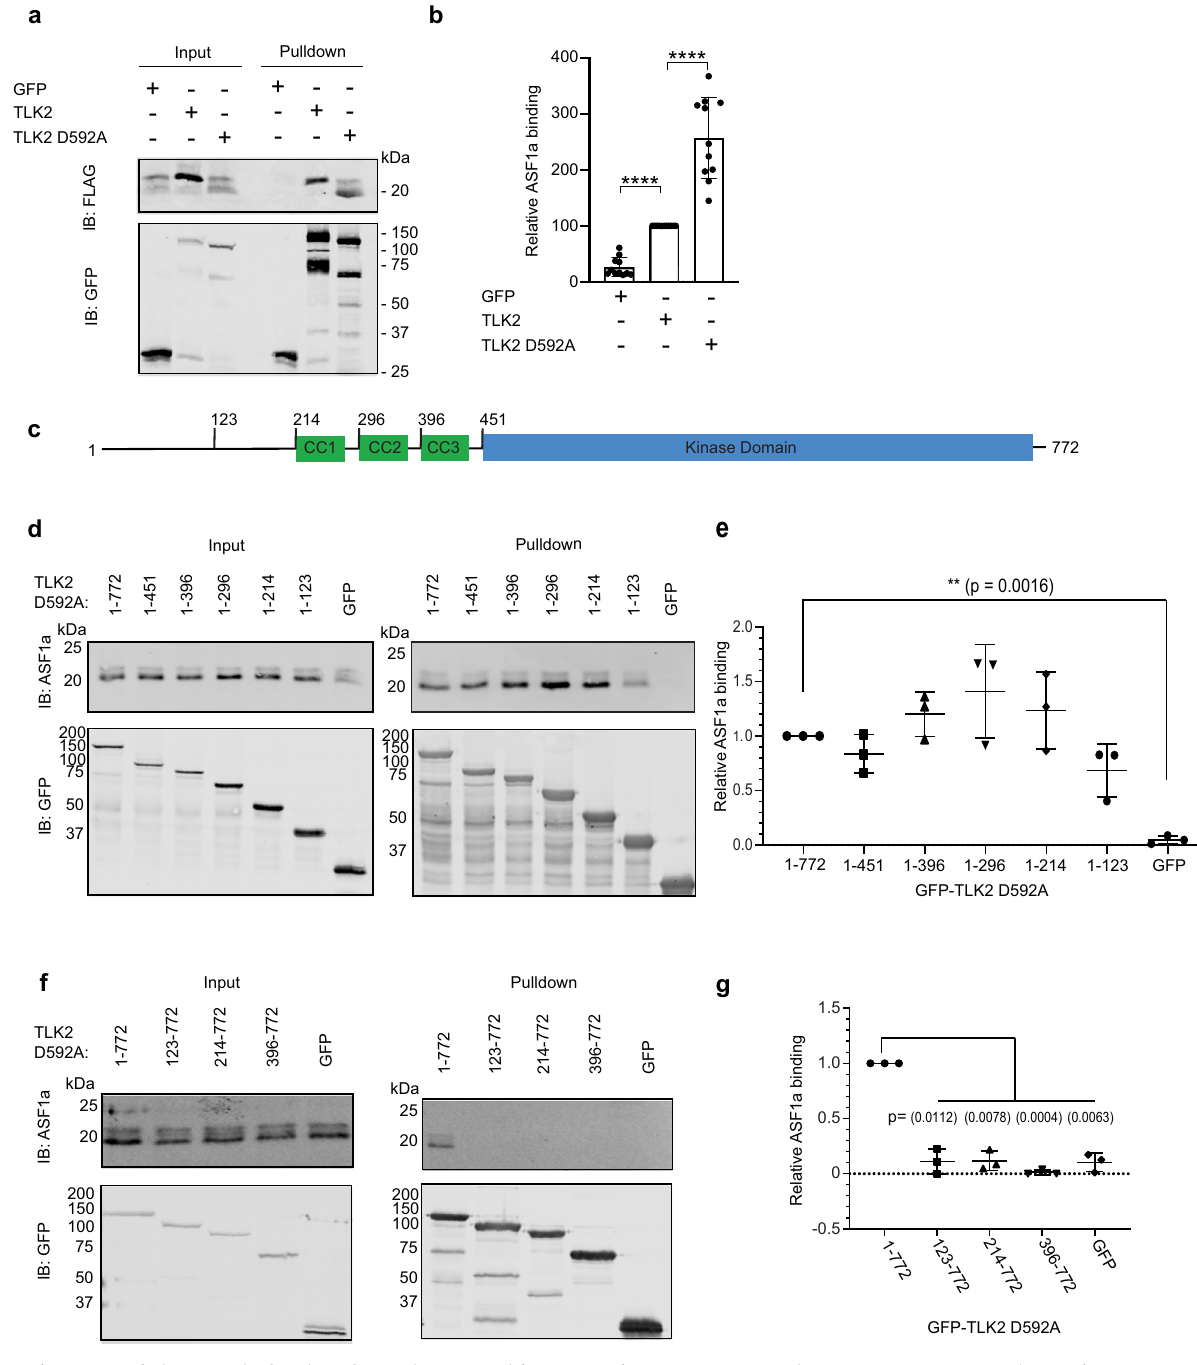
Fig. 2 The non-catalytic N-terminal region of TLK2 interacts with ASF1a. a , b GFP, GFP-TLK2, or kinase-inactive GFP-TLK2 (D592A) was co-expressed with FLAG-tagged ASF1a in HEK293T cells, cells were lysed and GFP proteins were precipitated with anti-GFP nanobodies coupled to Sepharose beads. Precipitated GFP proteins and co-precipitating FLAG-ASF1a were fractionated by SDS-PAGE and detected by immunoblotting. A representative experiment is shown in a . Relative ASF1a binding, normalized for FLAG-ASF1a input was quanti fi ed in 11 independent replicates, and mean ± SD is shown in b . Both unphosphorylated and phosphorylated forms of ASF1 were included in the analysis. **** p values < 0.0001 in one-way ANOVA with Tukey ’ s multiple comparison test. c Cartoon depicting TLK2 domain organization. Amino acid numbers are indicated. d – g GFP-TLK2 (D592A) and N-terminal or C-terminal detected by immunoblotting. Representative experiments are shown in d and f . and mean ± SD of three independent replicates are quanti fi ed in e and g . Signi fi cant difference from GFP-TLK2 D592A (1 – 772) calculated in one-way ANOVA with Dunnett ’ s multiple comparison test — p values shown on graph. Source data are provided as a Source Data fi